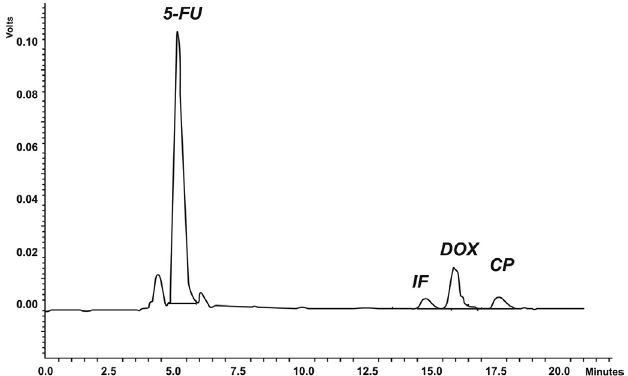
FIGURE 3 - Typical HPLC chromatograms, under optimal conditions evaluated: 20 µg mL -1 of fluoruracil (5-FU), ifosfamide (IF), doxorubicin (DOX) and cyclophosphamide (CP) extracted from plasma